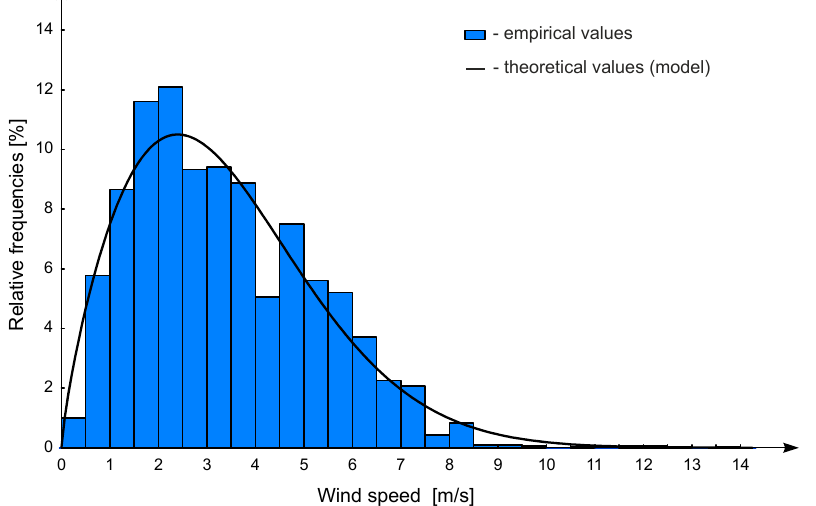
Figure 5. Empirical and theoretical wind speed probability density function at 110 kV overhead line locations.